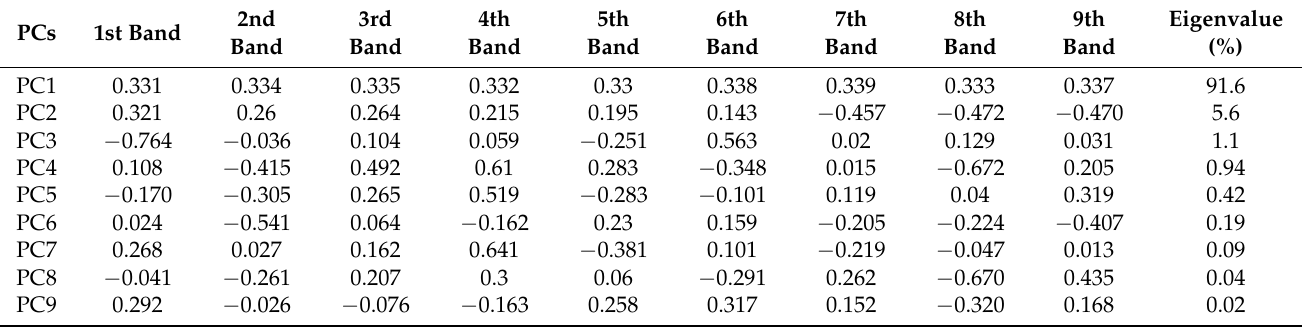
Table 2. Statistical results obtained from principal component analysis.